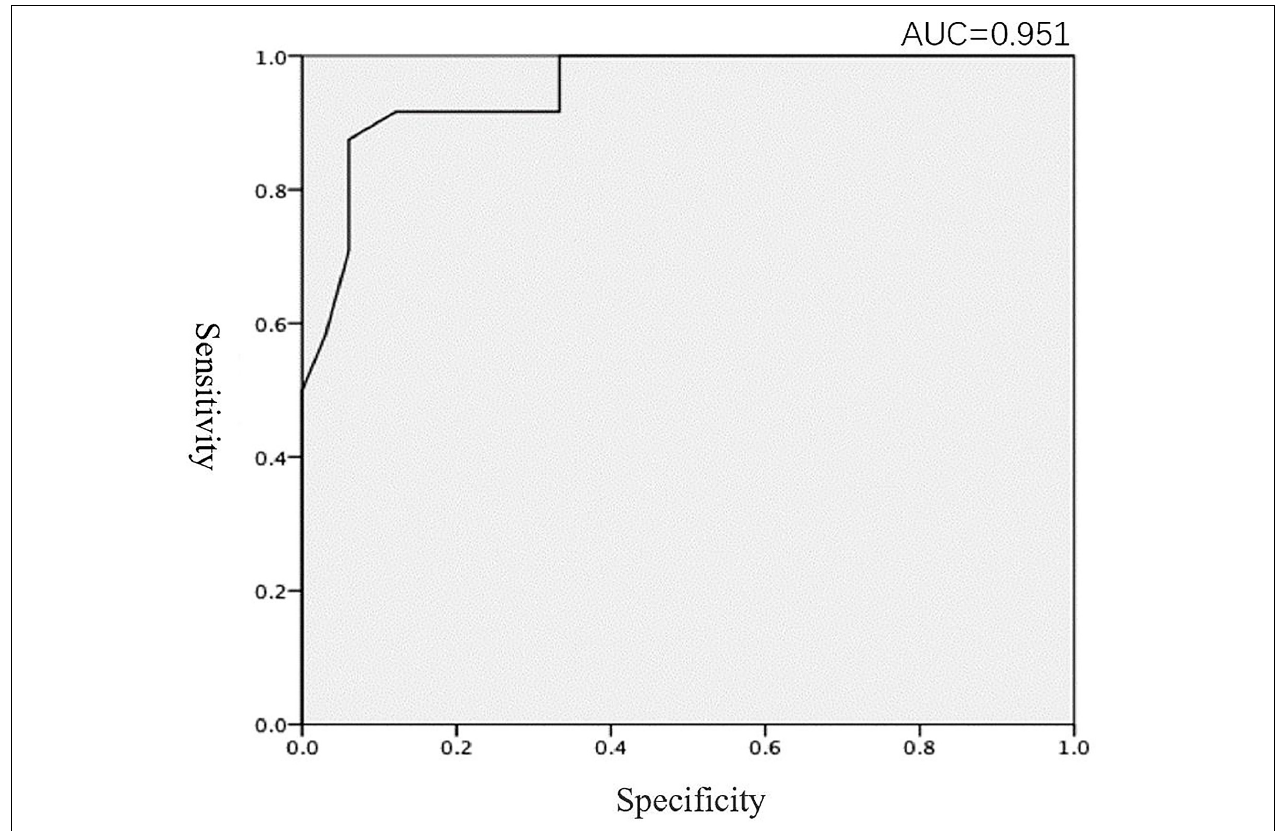
FIGURE 2 | ROC curve of the MoCA and OI scores.